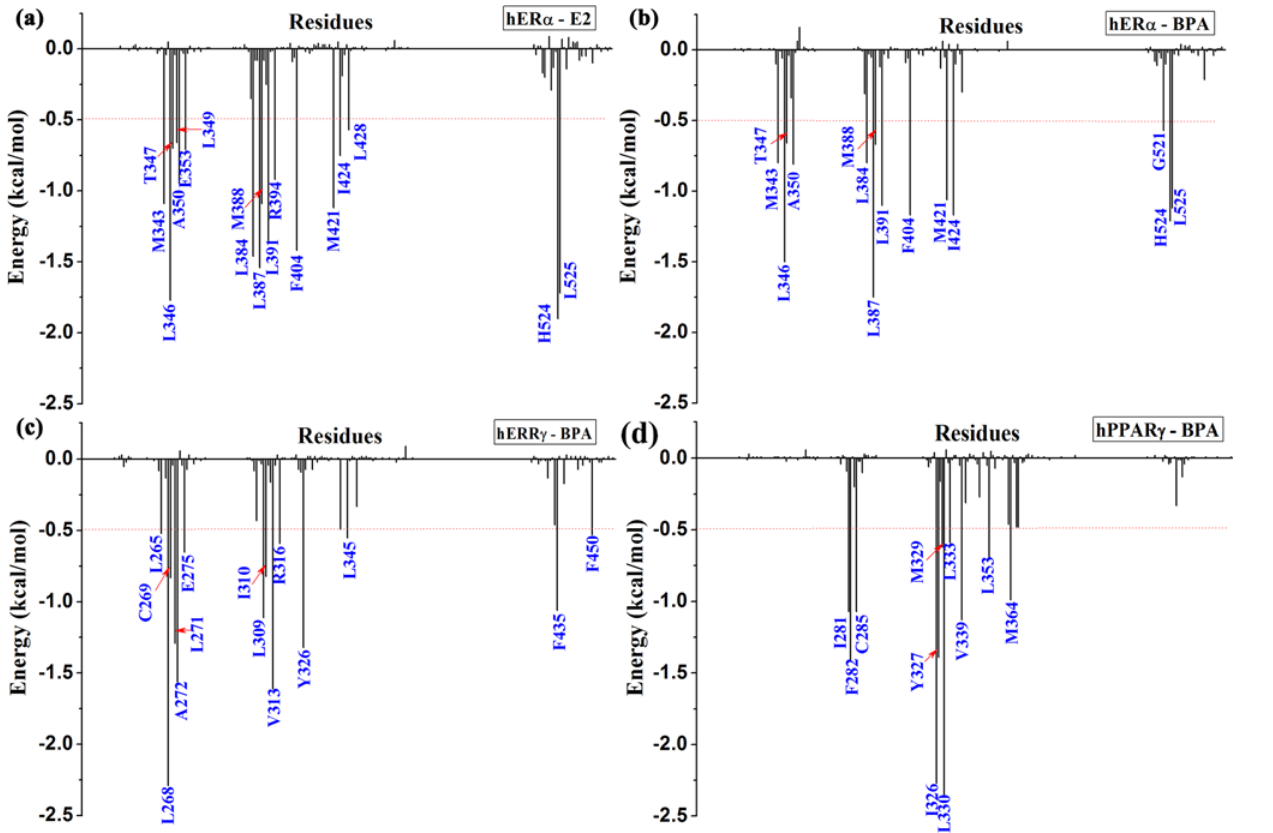
Fig 8. Intermolecular ligand-receptor per-residue interaction spectrum of the four